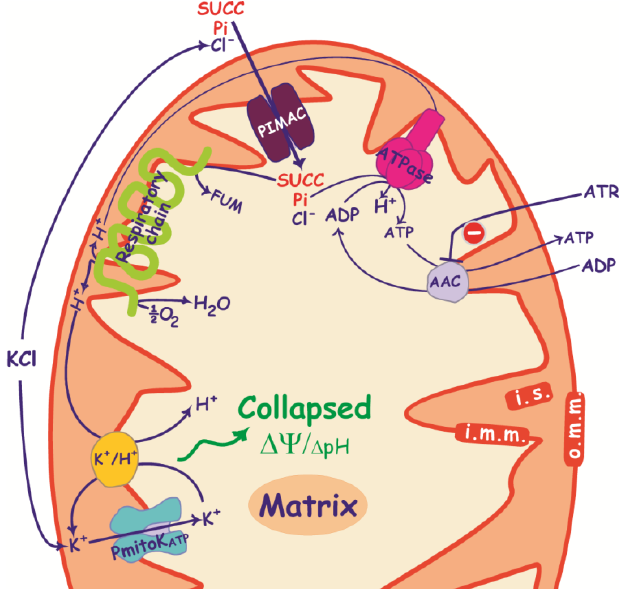
Figure 5. Uptake of Pi and succinate (SUCC), and ADP/ATP exchange in DWM fully . SUCC-oxidising DWM added with KCl at high concentration de-energized by PmitoK ATP present a strongly reduced ∆Ψ / ∆ pH due to PmitoK functioning. Under a number of ATP experiments, a complete ∆Ψ / ∆ pH collapse was even observed. Unexpectedly, in the absence of a measurable pmf, DWM regularly synthesize ATP; under this condition, SUCC and Pi uptake may occur via PIMAC, whereas the ADP/ATP exchange occurs via AAC despite the absence of ∆Ψ (for details see the text). AAC, ADP/ATP carrier; FUM, fumarate; ATR, atractyloside; i.m.m., inner mitochondrial membrane; i.s., intermembrane